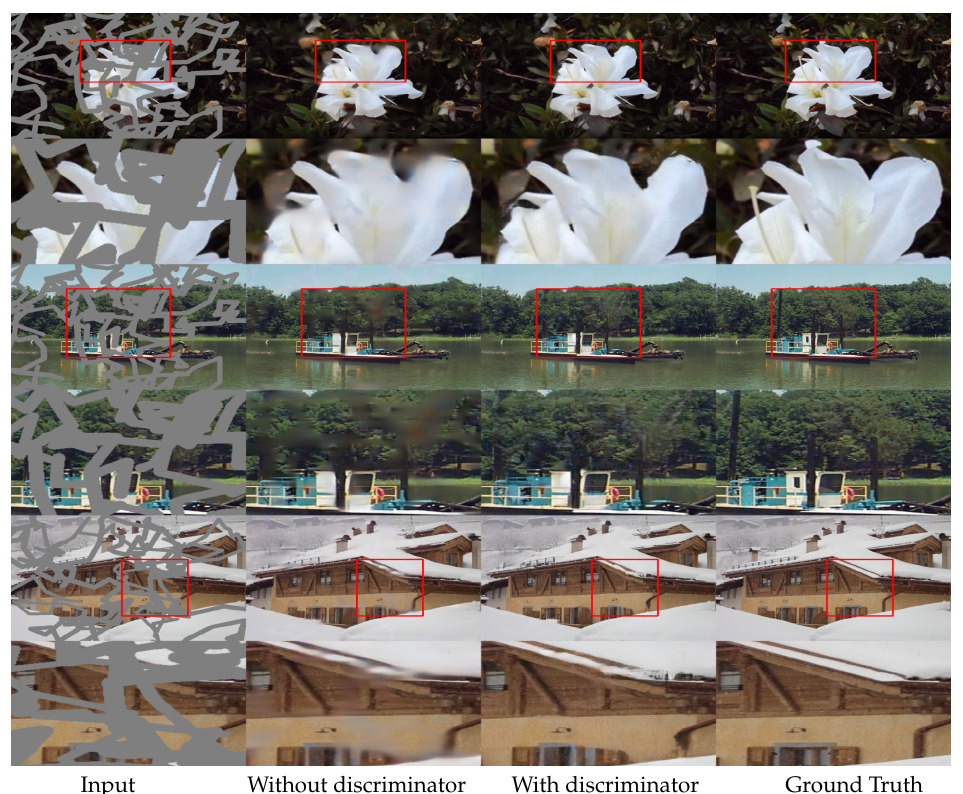
Figure 10. Ablation study for the effect of the discriminator in the proposed model in Places365 dataset [21]. From left: input image, output (without discriminator), output (with discriminator), and the ground